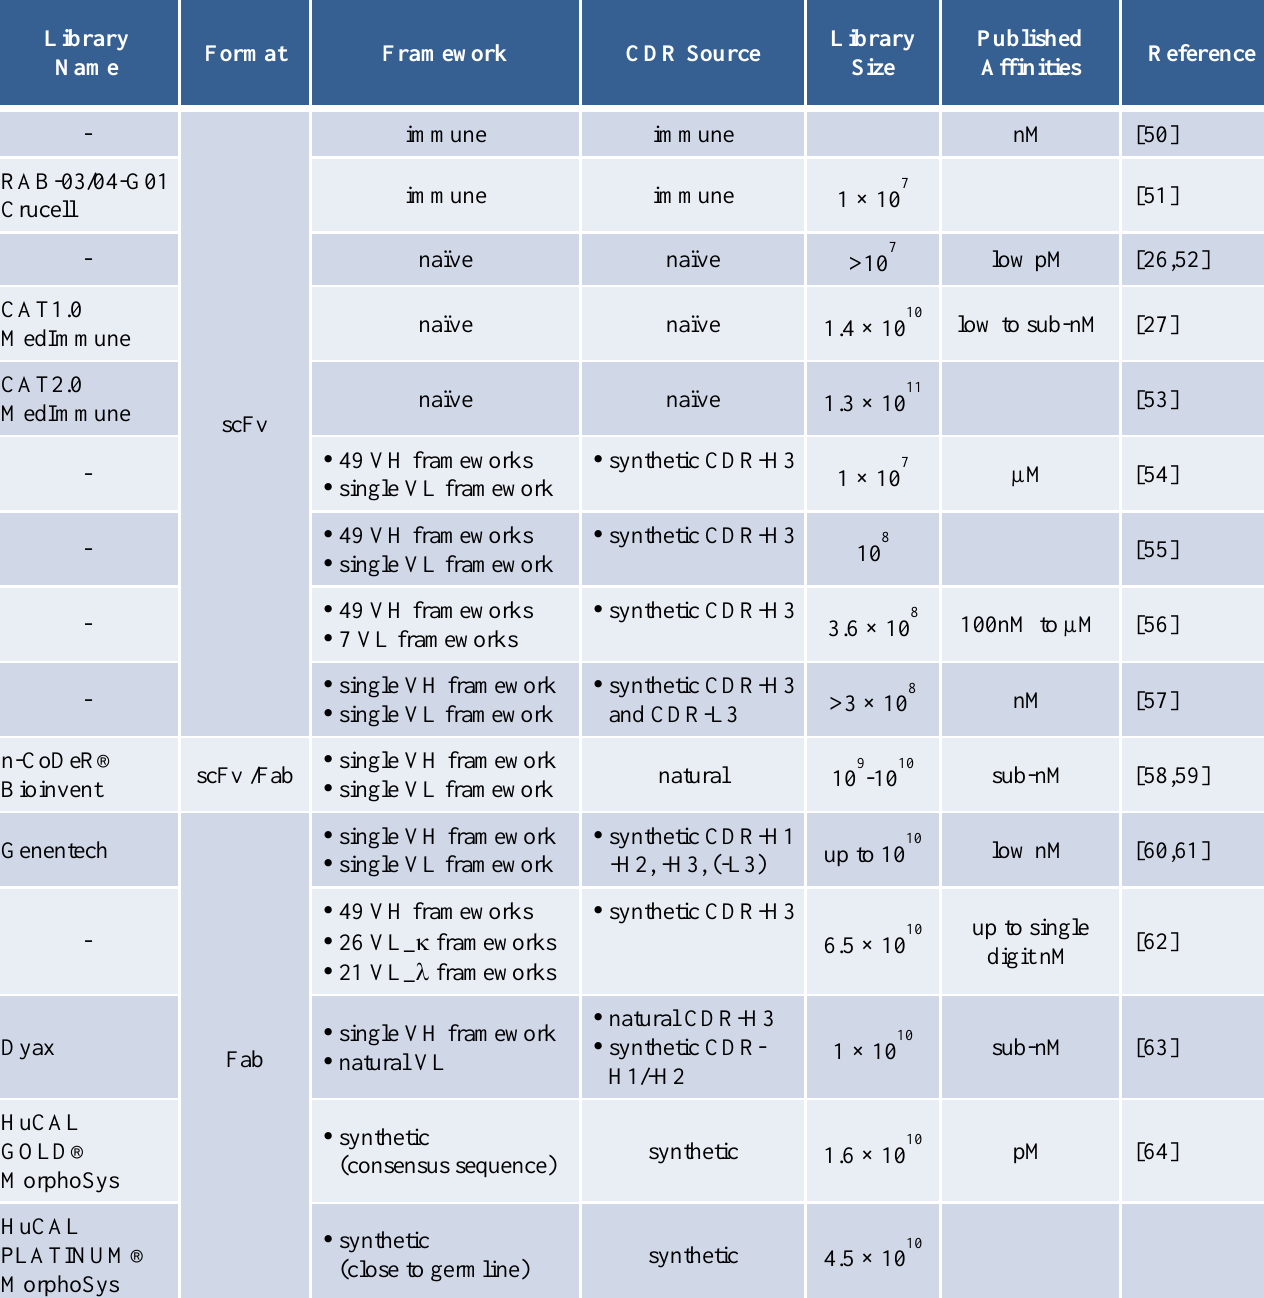
Table 1. Representative examples of phage display antibody libraries (scFv and Fab format) published. All phage display libraries are summarized in brief by key parameters as framework and CDR ‘source’, library size and highest affinities described. Selected references from the literature are given for each